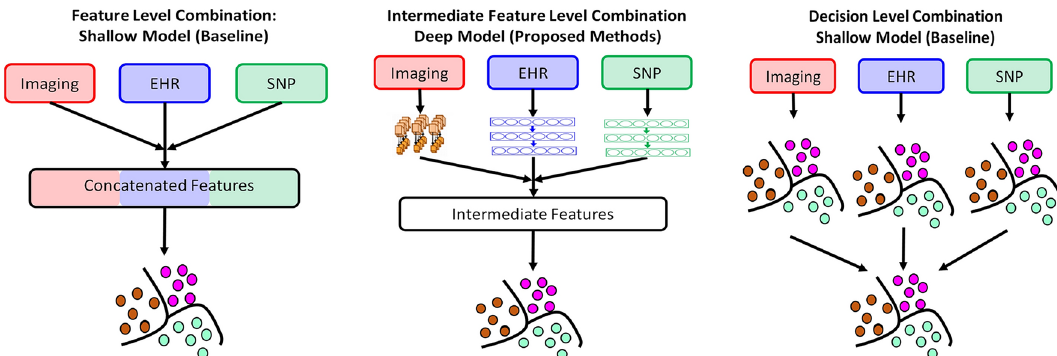
Figure 2. Deep model for data integration compared with shallow models of data integration. ( a ) Feature level integration on shallow models, where the features are concatenated before passing into shallow models. ( b ) Deep intermediate feature level integration where the original features are transformed separatelyusing deep models prior to integration and prediction. ( c ) Decision level integration where voting is performed using decisions of individual classifiers. In this study, we comparee the performance of deep intermediate level integration against shallow feature and decision levels integrations for the prediction of Alzheimer’s stages.